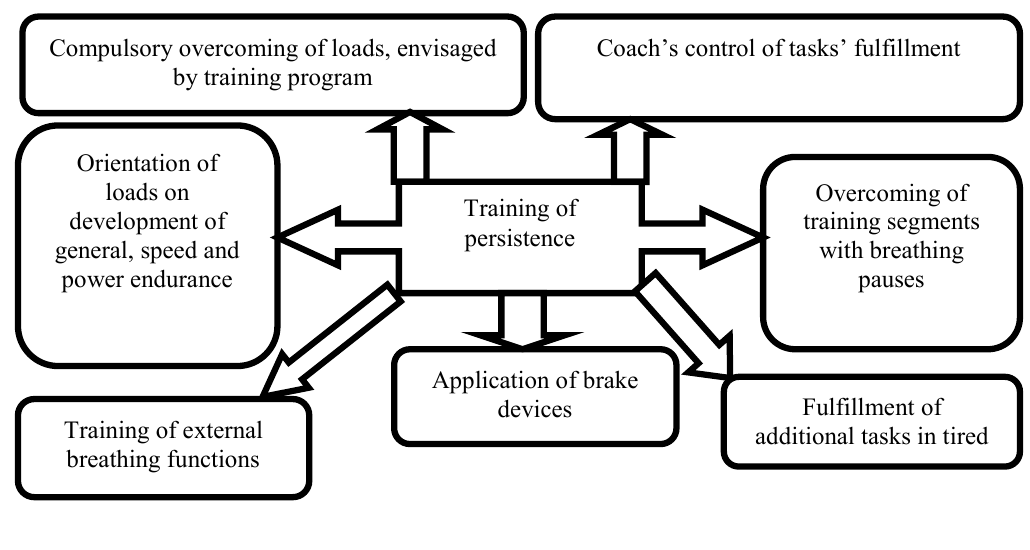
Fig.1. Pedagogic techniques of persistence